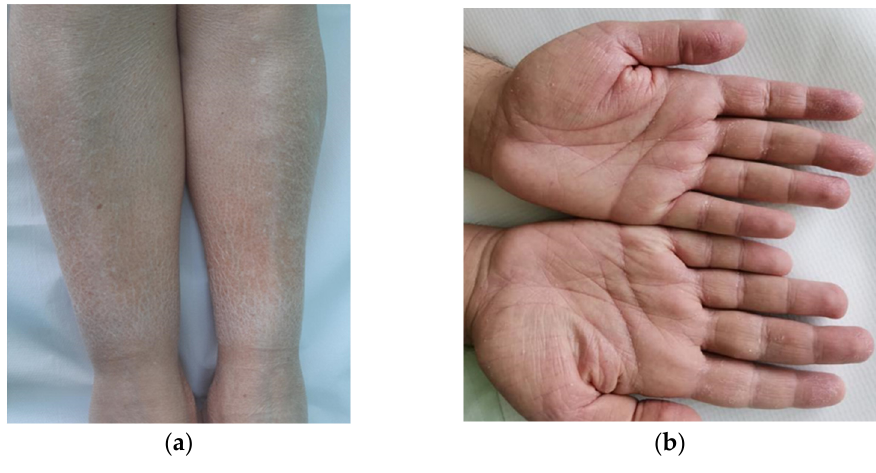
Figure 1. Cutaneous xerosis ( a ); palmar hyperlinearity ( b ).